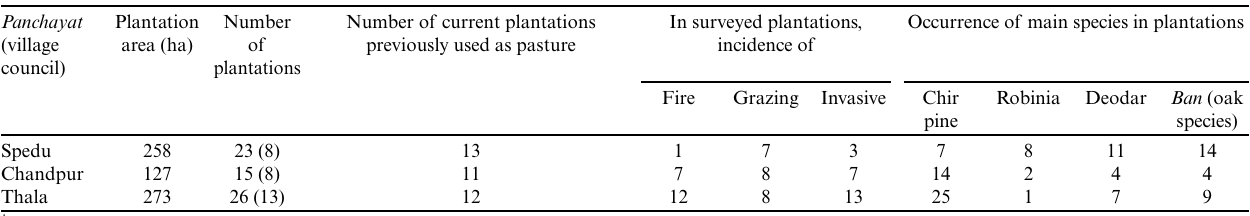
Table 2 . Plantations in the study area. †